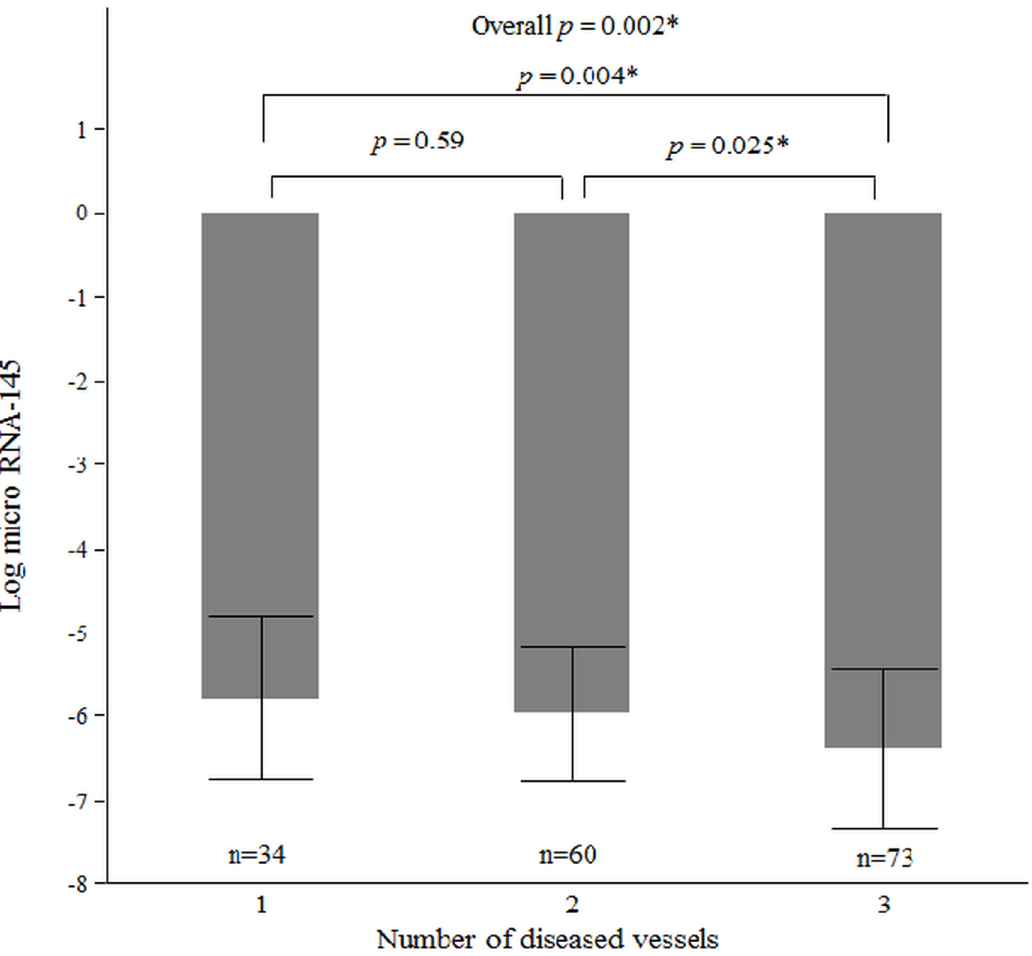
Fig 1. Association between plasma miRNA-145 levels and number of diseased vessels. These bars represent averages of plasma miRNA-145 levels among patients with single-, double- and triple-vessel CAD. T-bars indicate standard deviation. Patients with three-vessel disease have significantly lower levels of miRNA-145 compared with the rest of the groups. Levels were not significantly different between patients with single- and double-vessel CAD. * p < 0.05; CAD, coronary artery disease, RNA, Ribonucleic